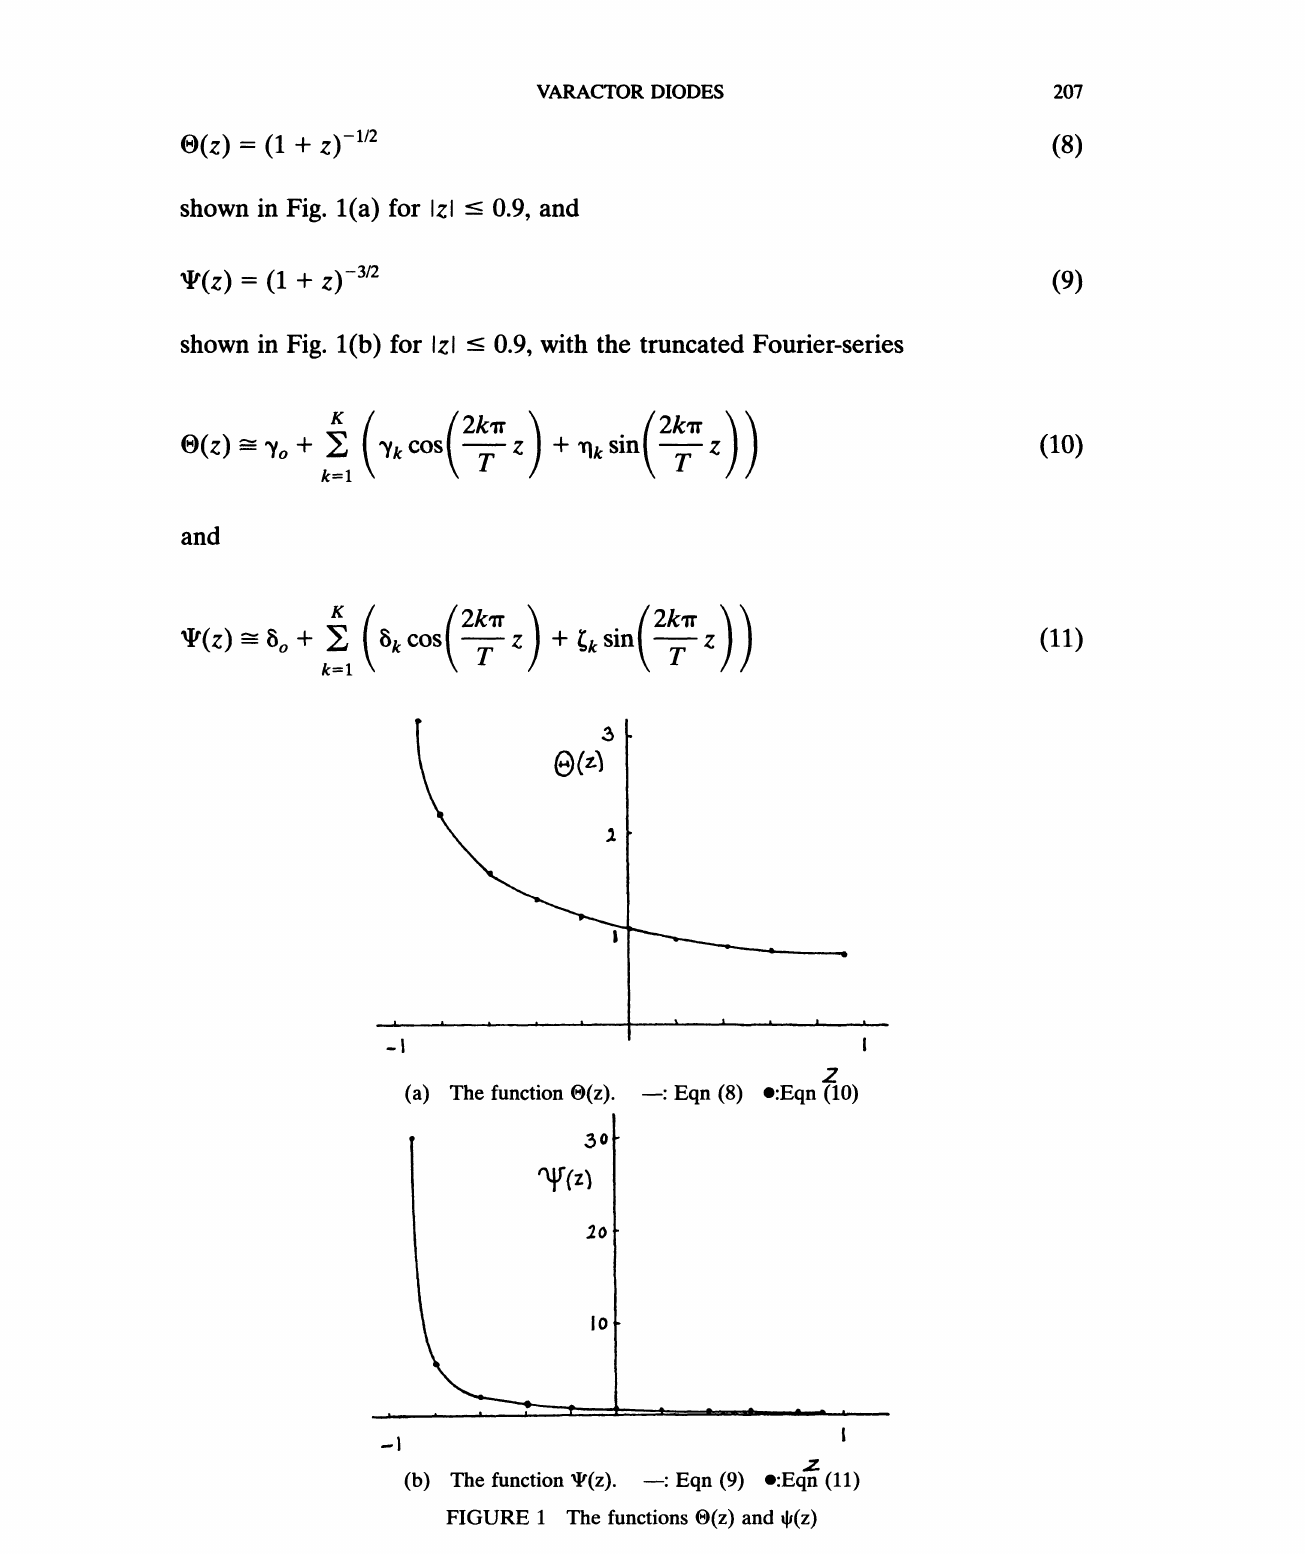
--: Eqn (9) e:Eqn The functions O(z) and (z)